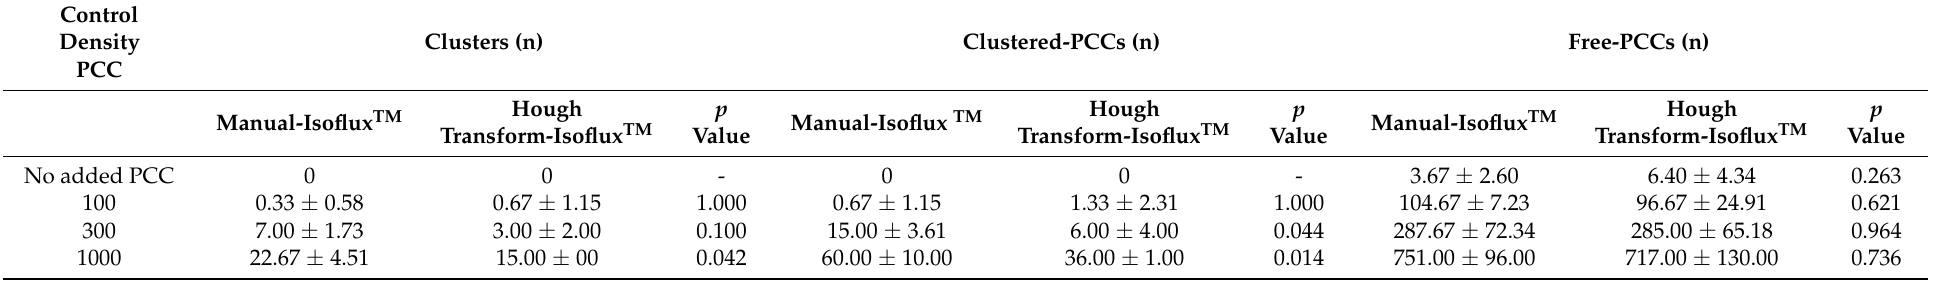
Table 2. Breakdown of clusters, clustered-PCCs, and free-PCCs. Data are presented with the mean and